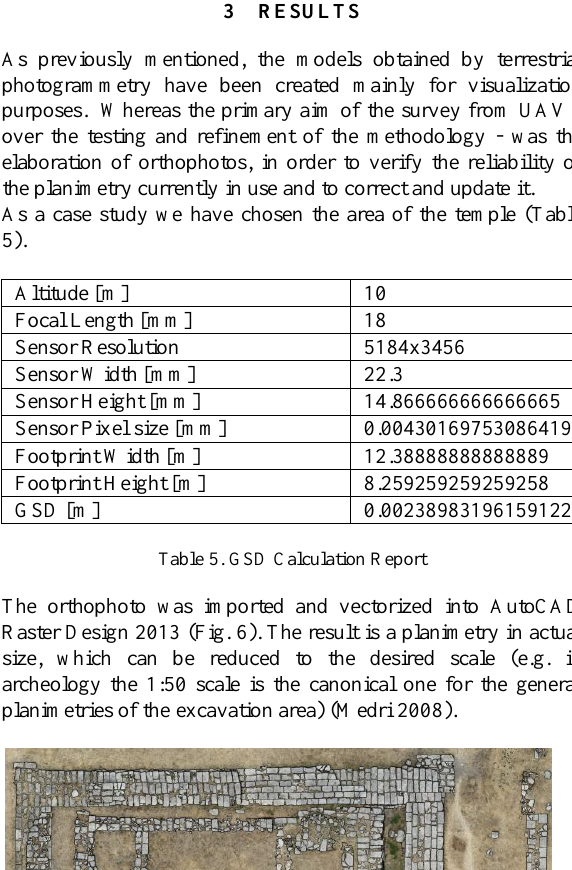
Figure 4. 3D model of the southern sector with camera positions In both flights, the SLR camera was set to shoot in aperture priority (11), with focal length 18 mm, ISO 100, fixed focus and auto white balance. The elaboration of the models required 4 hours and 2 hours respectively.